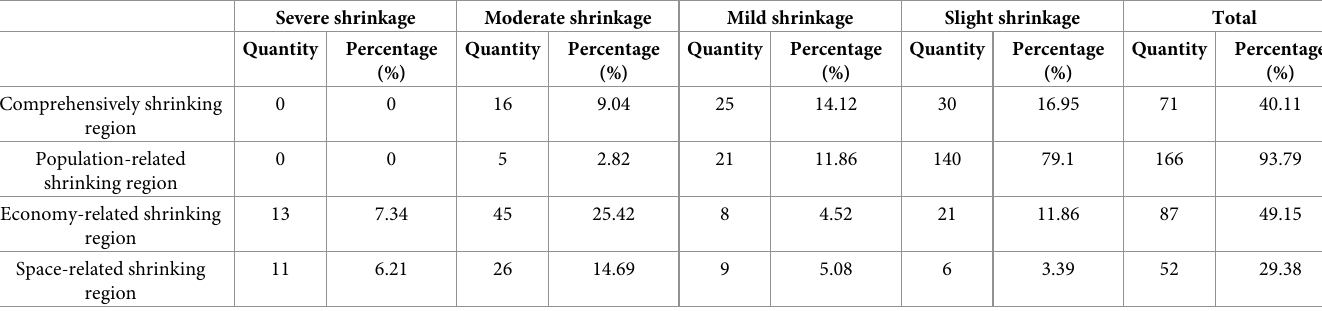
Table 4. Hierarchical statistics of regional shrinkage of the three northeastern provinces from 2012 to